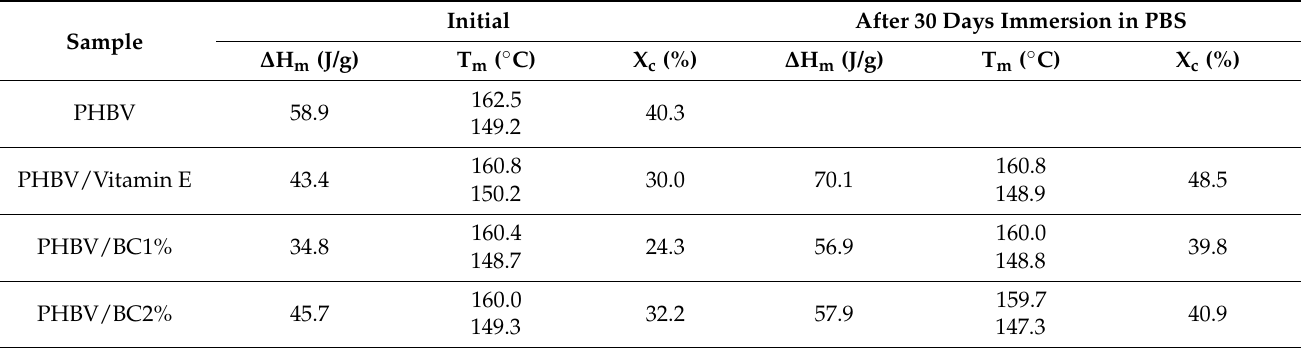
Table 3. DSC parameters obtained for PHBV/BC biocomposites as compared with neat